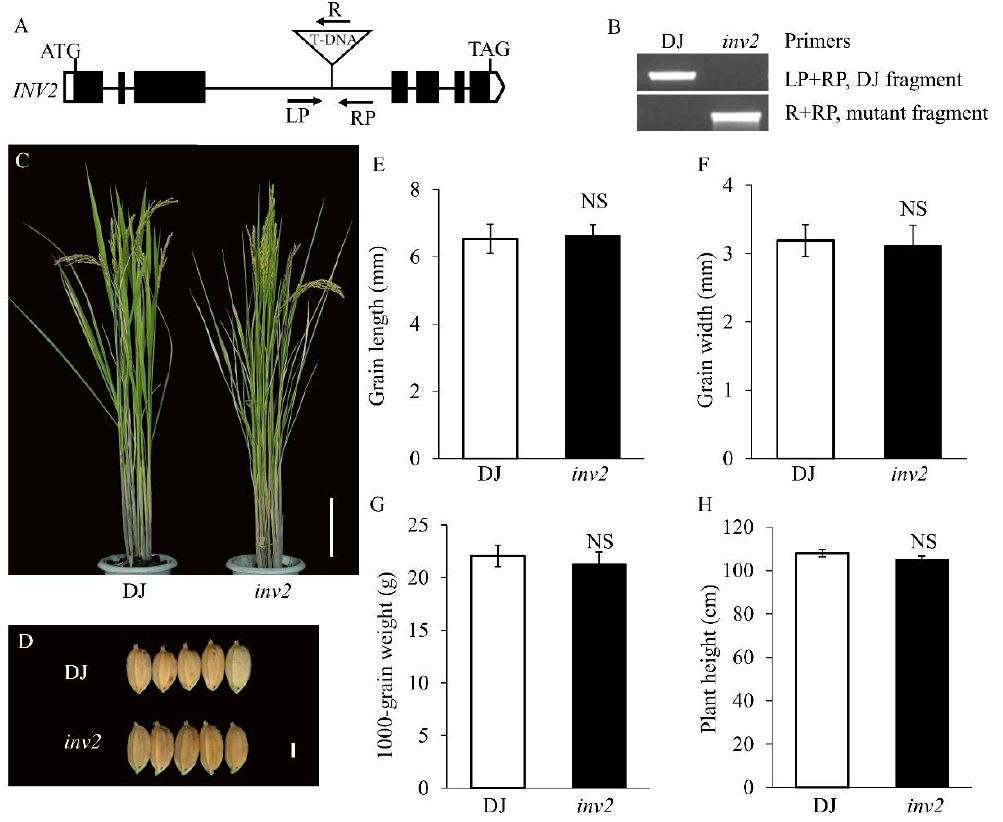
Figure 8. Phenotypic characterizations of INV2 T-DNA insertion mutant. ( A ) T-DNA insertion site of the inv2 mutant. The triangle indicates the T-DNA insertion site in the inv2 mutant. Black boxes, lines and white boxes represent exons, introns and the untranslated regions, respectively. The start codon (ATG) and the stop codon (TAG) are indicated. ( B ) Gel data showing the presence of DJ and inv2 alleles. ( C ) Plant comparison of DJ, inv2 mutant at the maturity stage. Bar = 10 cm. ( D ) Morphology of grain shape in DJ, inv2 mutant. Bar = 2 mm. ( E – H ) Statistical data of the grain length ( E ), grain width ( F ), plant height ( G ), and 1000-grain weight ( H ) in DJ and inv2 mutant. Data are given as means ± SD. Student’s t-test was used to generate the p values; NS indicate no significant differences. Table 2. Agronomic traits of Dongjing (DJ) and inv2.